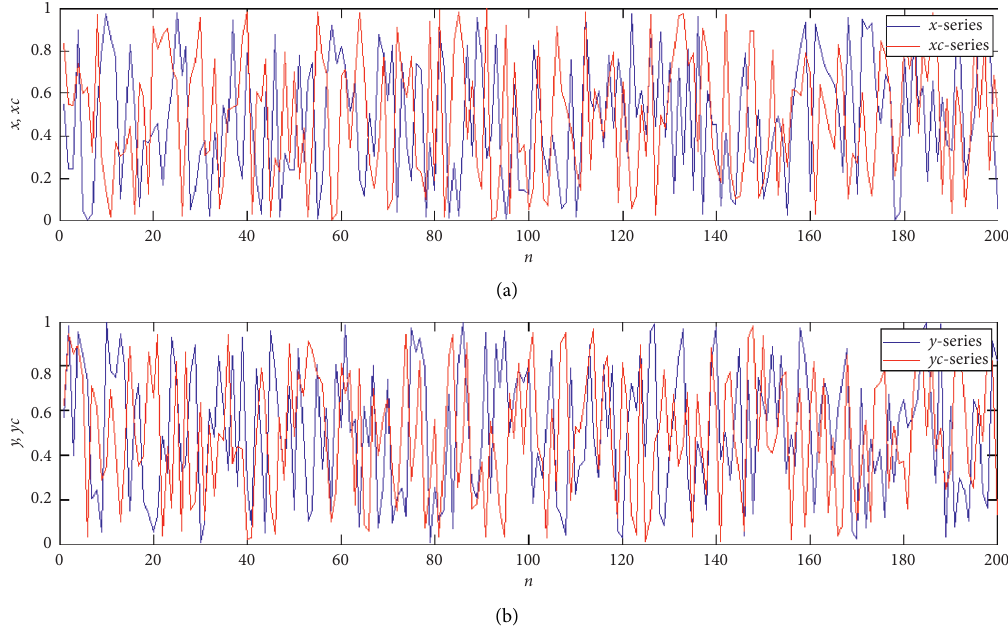
Figure 3: Chaotic time series generated from proposed hyperchaotic map: (a) X and Xc sequence; (b) Y and Yc sequence.